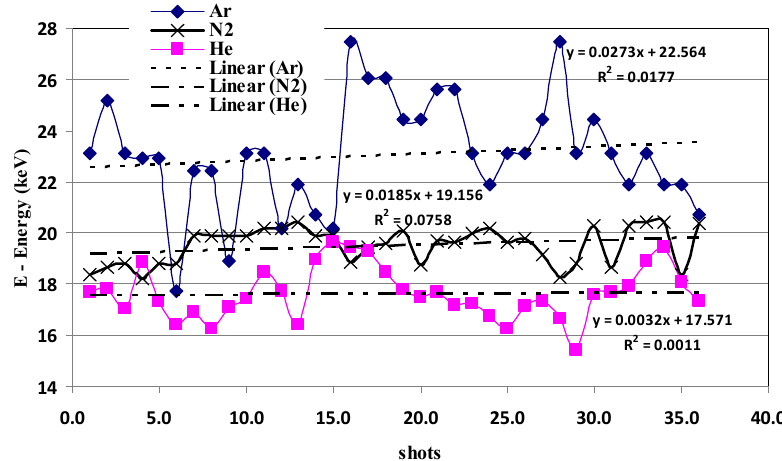
Figure 8. Electron energy for 36 shots of AECS PF-1 at 0.6 Torr for He, N 2 , and Ar gases.